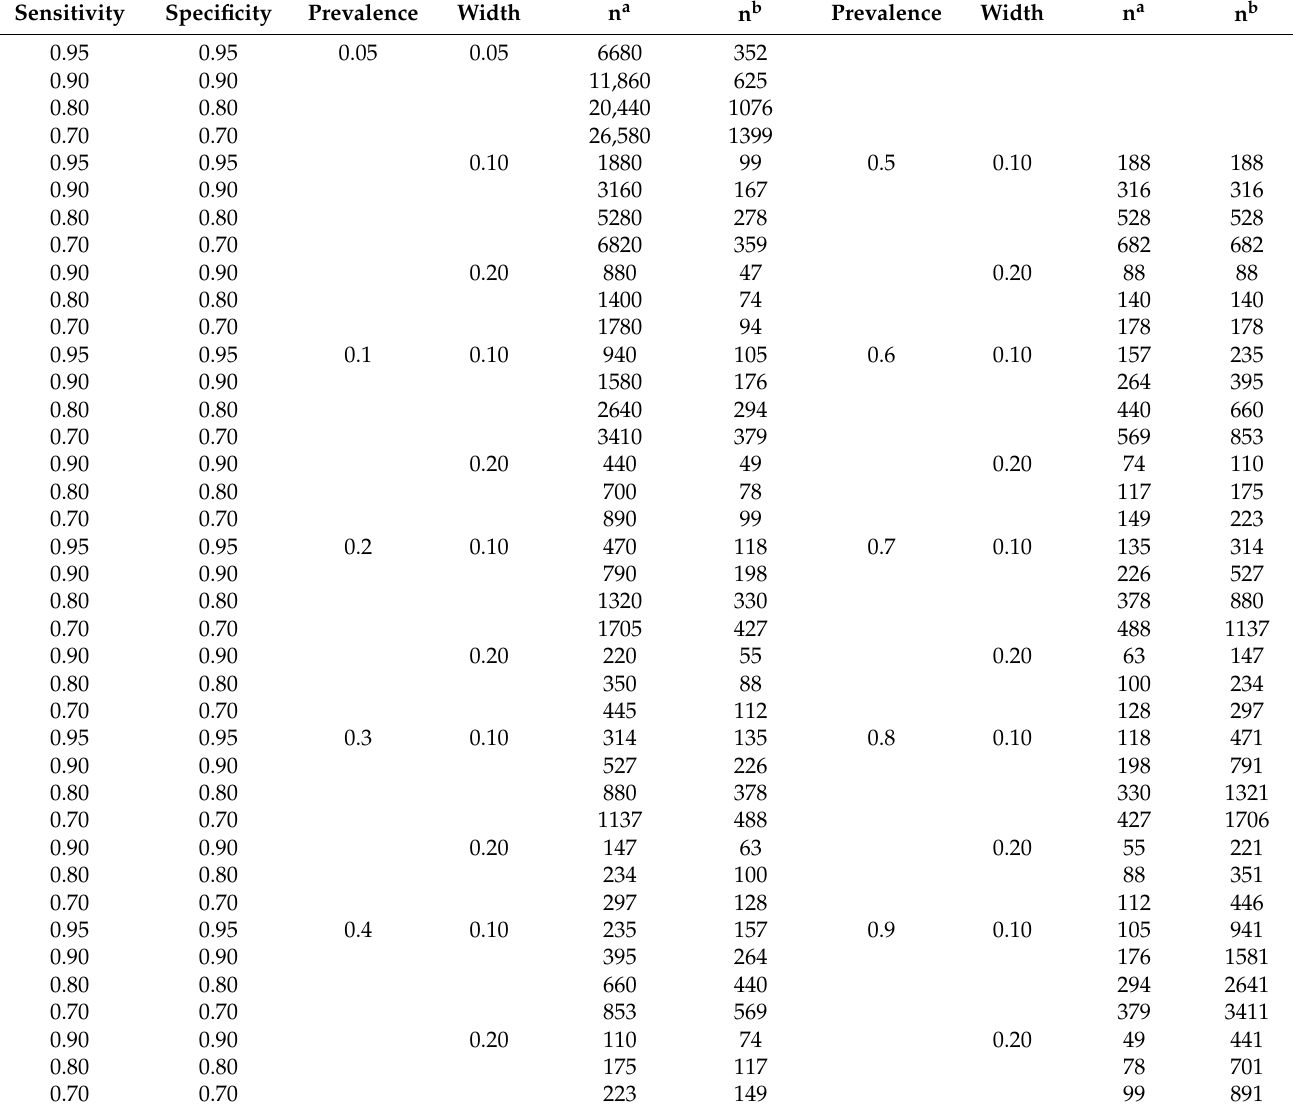
Table 2. Recommended sample size requirements for diagnostic research with various specifications of sensitivity, specificity, prevalence, and desired width that are based on 95% confidence interval.